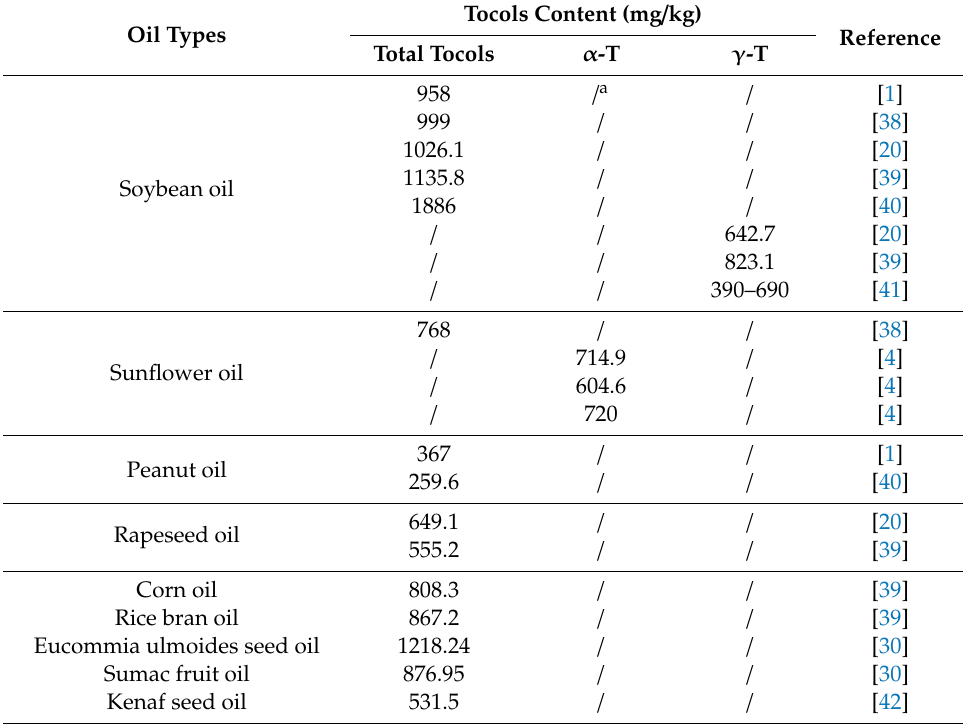
Table 2. The data of tocol contents in di ff erent vegetable oils extracted from a literature